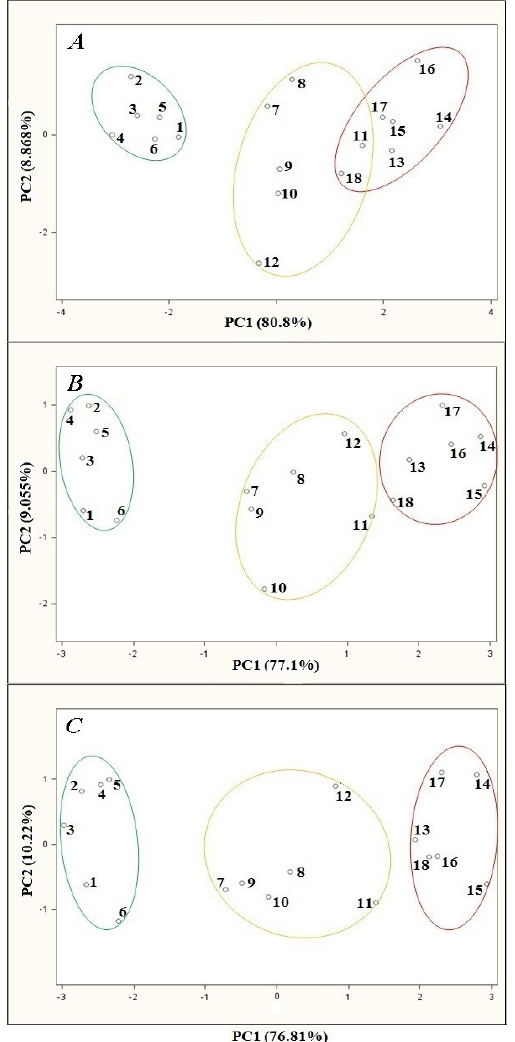
Figure 4. PCA results for samples of agricultural distillates obtained for different volumetric flow rate: ( A ) 5 L/h; ( B ) 10 L/h; ( C ) 15 L/h; points: 1–6—high quality class distillates (green), 7–12—medium quality class distillates (yellow), 13–18—low quality class distillates